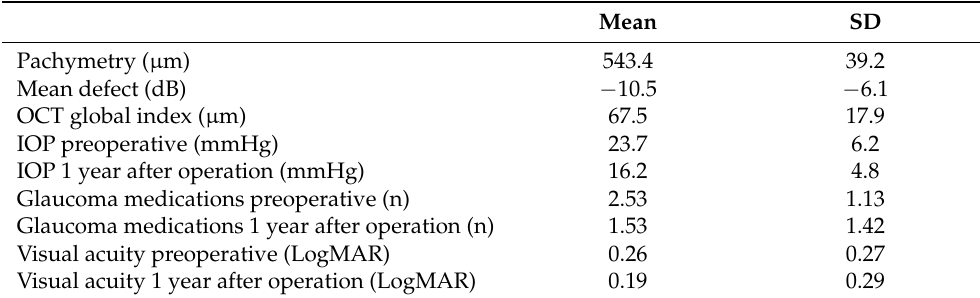
Table 1. Patient’s ophthalmological characteristics. OCT: Optical Coherence